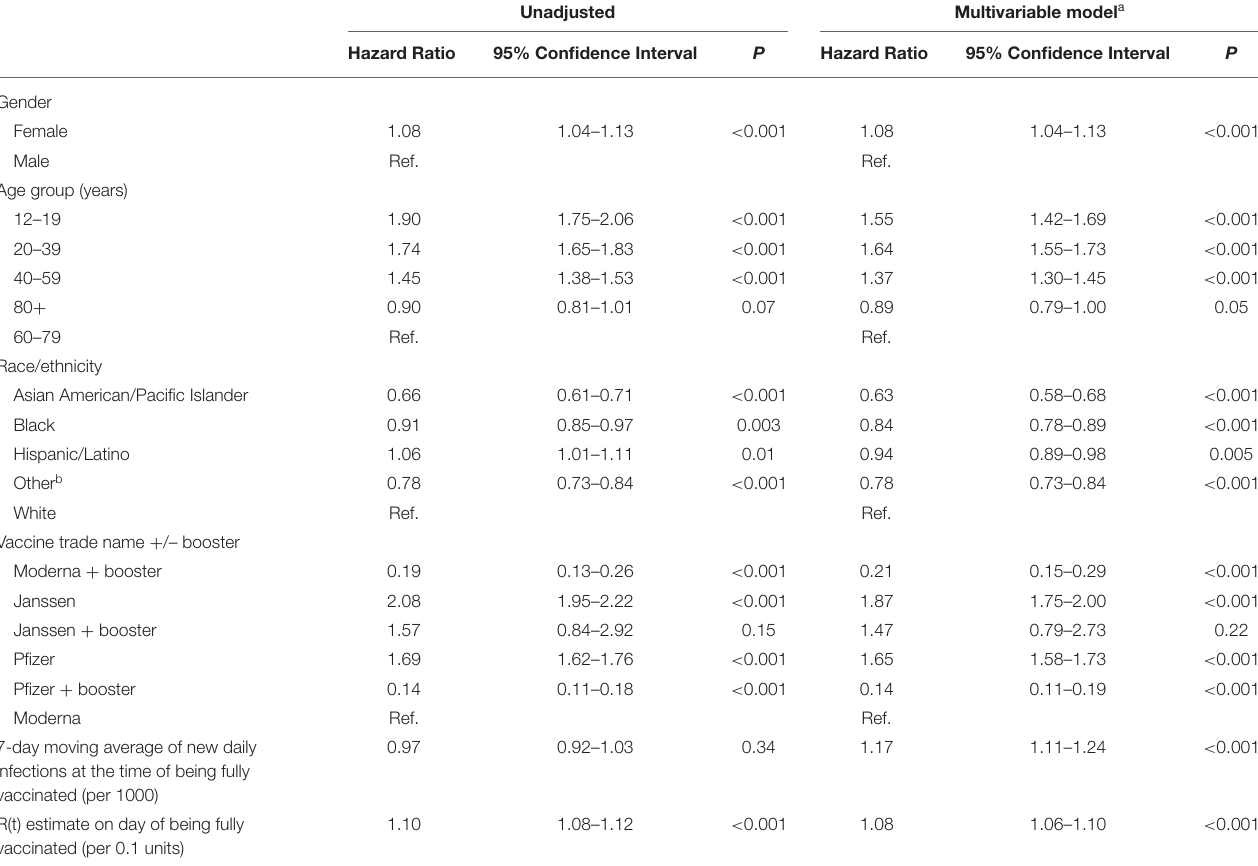
TABLE 3 | Cox proportional hazards model for time until breakthrough infection among subgroups of 1,272,611 fully vaccinated residents in Harris County